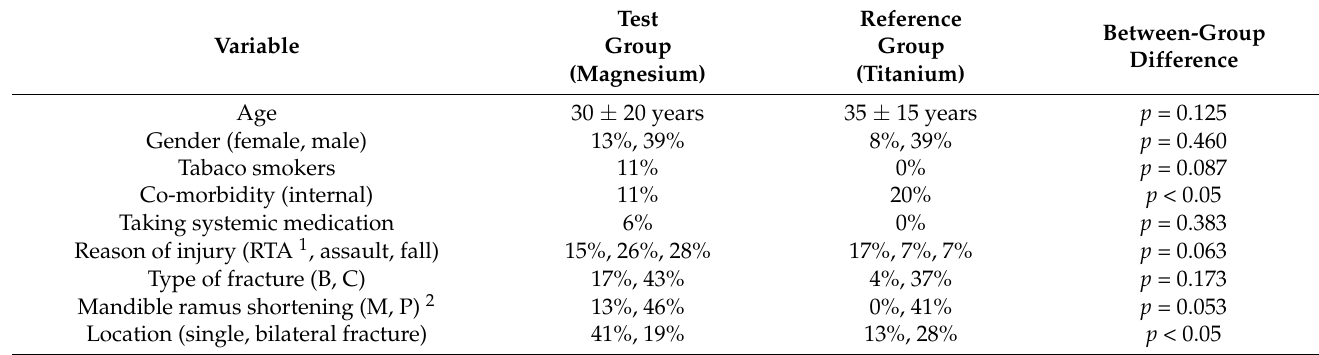
Table 1. Data describing the test group versus the reference